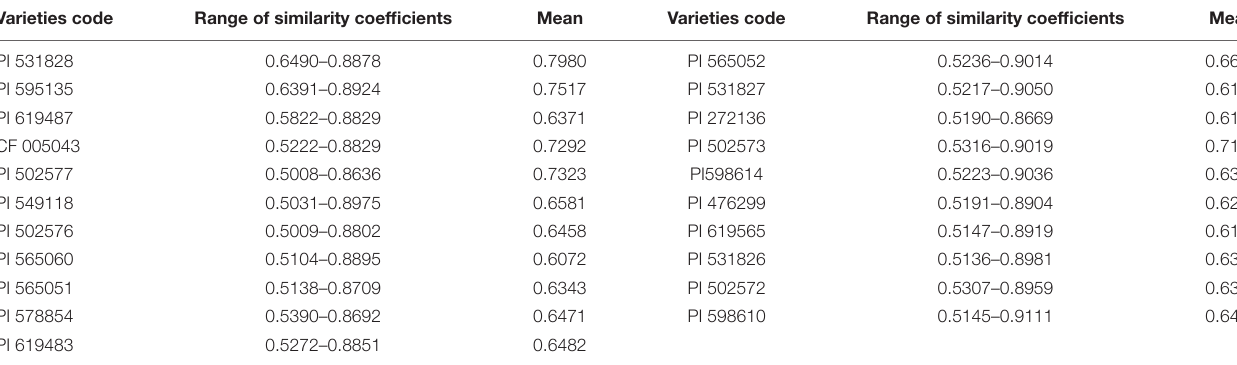
TABLE 5 | Range of similarity coefficients on 480 simple plant of Psathyrostachys juncea germplasm. Varieties code